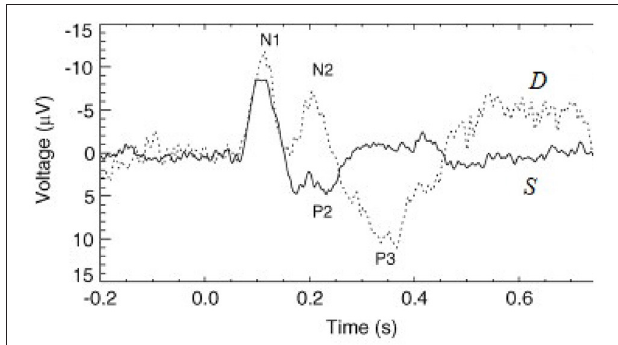
FIGURE 1 | Examples of typical standard ( S , solid line) and deviant ( D , dashed line) evoked responses to auditory stimuli in an auditory oddball experiment (Kerr et al., 2009). The traditional phenomenological “components” (peaks and troughs) are labeled, where N1 and P2 indicate a negative deflection around 100 ms and a positive one around 200 ms, respectively, for